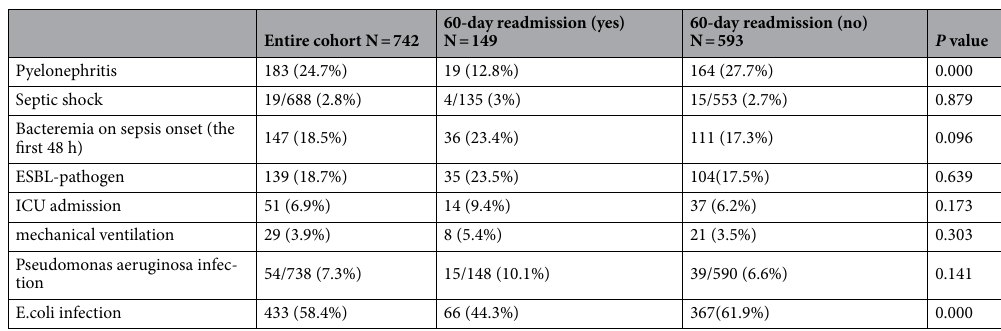
Table 2. Infection presentation. Abbreviations: ESBL, Extended-spectrum beta-lactamases; ICU, intensive care